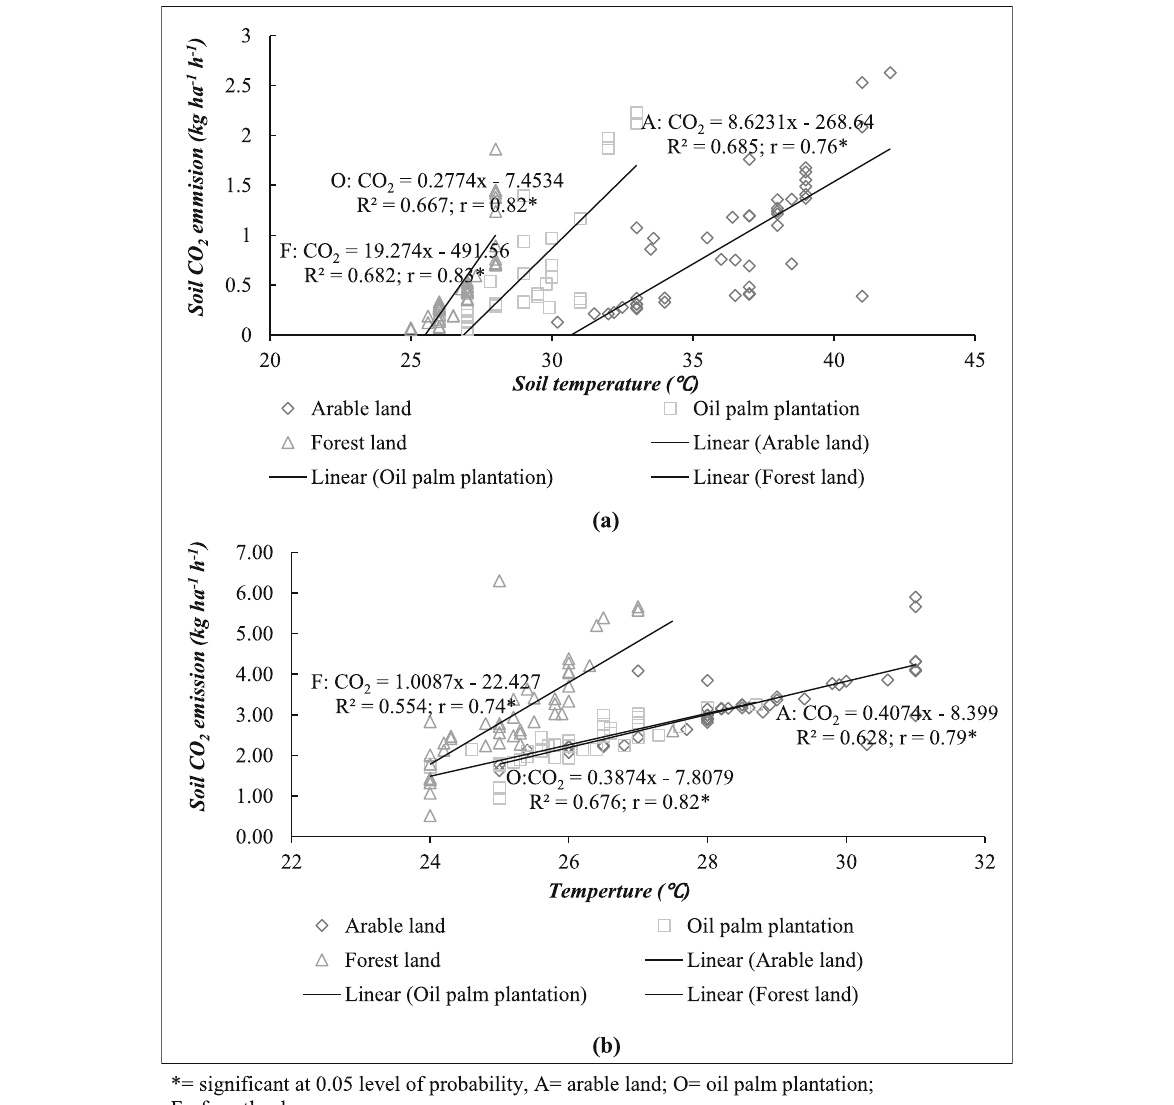
Fig. 4 Relationships between soil temperature and CO 2 production in the land-use systems for both dry ( a ) and wet ( b )